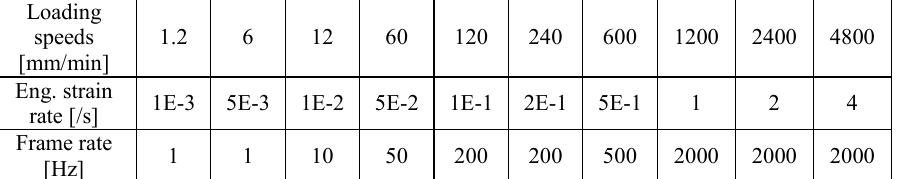
Table 1. Loading speeds and corresponding frame rates for UT